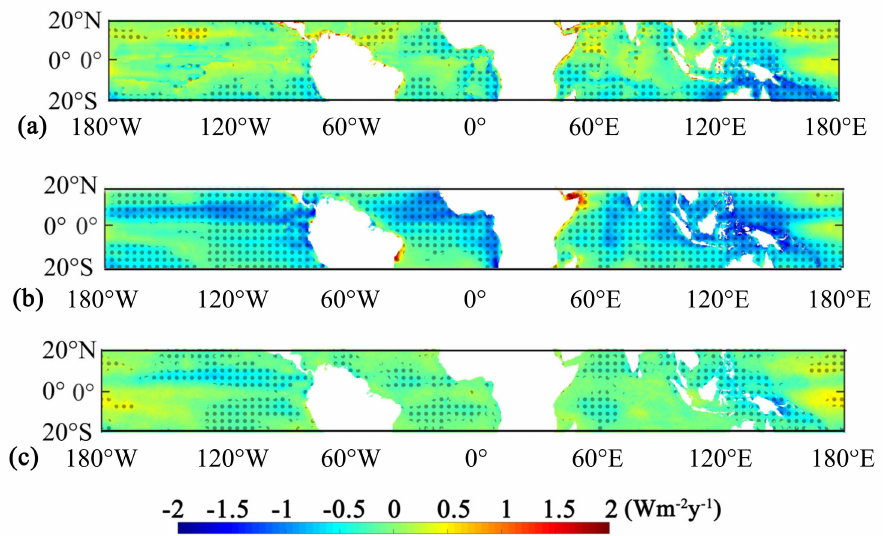
Figure 14. Spatiotemporal variations in the annual mean sea-surface R n during 1988 to 2013 by linear regression model for ( a ) the corrected J-OFURO3, ( b ) the original J-OFURO3, and ( c ) the ERA5. The pixels marked with a dot indicate their statistical significance, with the p -values <=